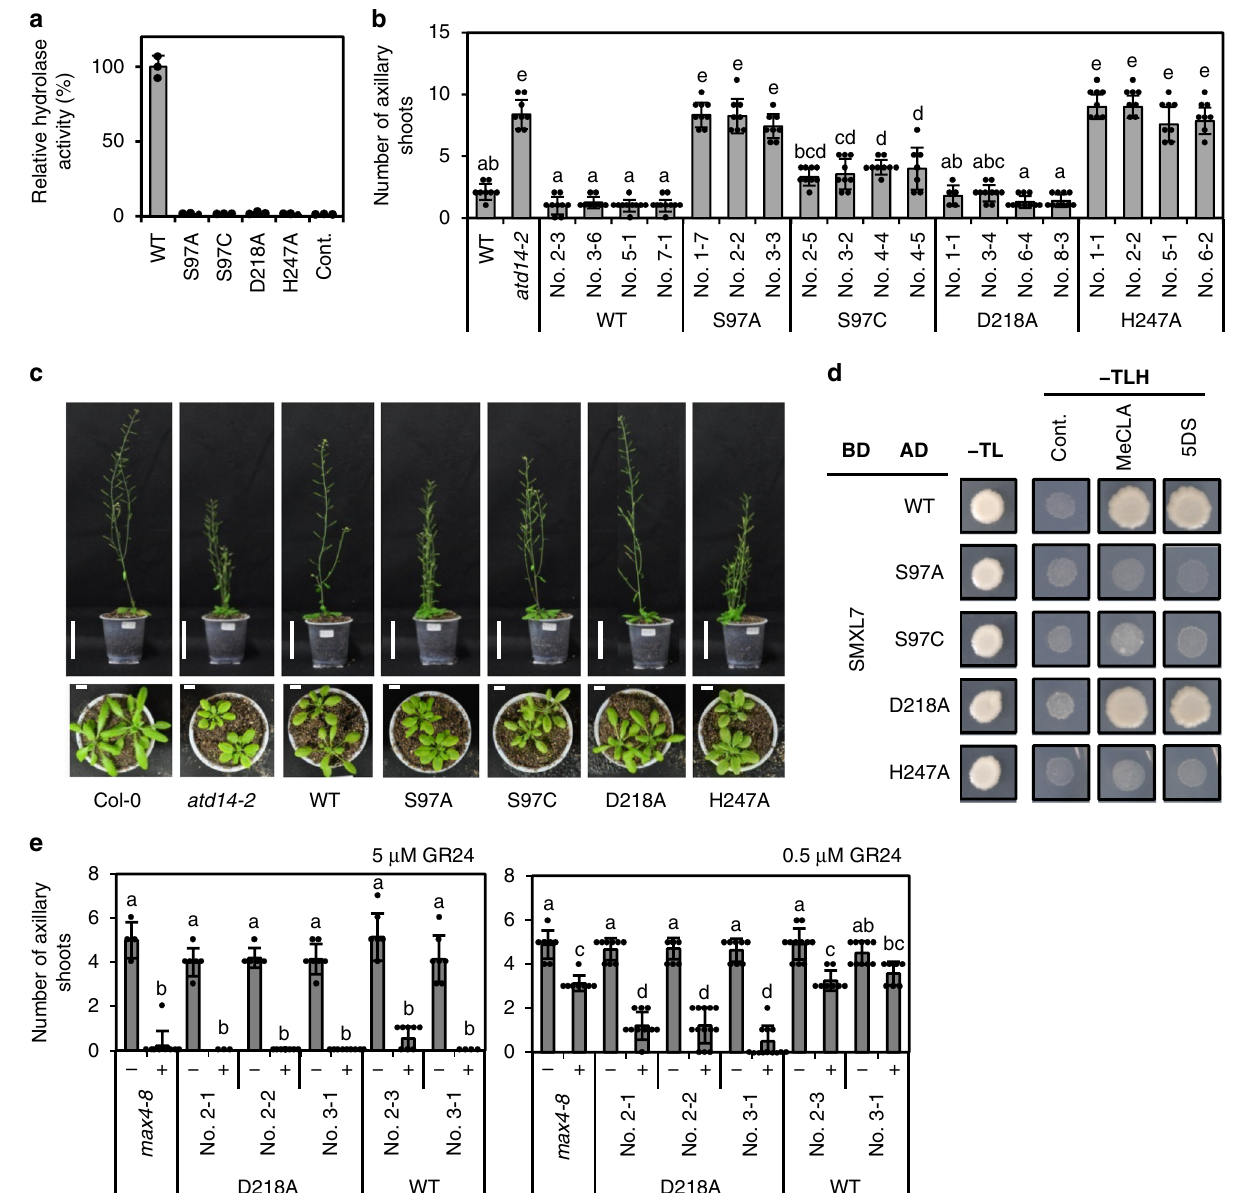
Fig. 3 In vitro and in vivo functional analysis of catalytic triad mutants of AtD14. a Hydrolysis activities of catalytic triad mutants of AtD14 using 1 μ M of 5DS as a substrate. Data are the means± SD ( n = 3). The control reaction (Cont.) is for MBP protein only. b No. of axillary shoots (over 5 mm) of Arabidopsis transgenic plants expressing each catalytic triad mutant of AtD14 in the atd14-2 mutant background. Data are the means ± SD ( n = 5 – 10, Different letters indicate signi fi cant differences at P < 0.05 with Tukey-kramer multiple comparison test.). c Phenotypes of Arabidopsis transgenic plants expressing each catalytic triad mutant of AtD14. Mature 50 days old plants phenotypes (upper panel) and leaf morphology phenotypes of 25 days old plants (lower panel) are shown. Scale bars = 5 cm (upper panel), 1 cm (lower panel). d Y2H analysis of the interaction between SMXL7 and each catalytic triad mutant of AtD14. Yeast transformants were spotted onto the control medium (SD − Leu/ − Trp ( − TL)) and selective medium (SD − Leu/ − Trp/ − His ( − TLH)) in the absence or presence of SLs (10 μ M rac -MeCLA or 10 μ M 5DS). Control (Cont.) is acetone only. e Shoot branching inhibition assays of the Arabidopsis transgenic lines expressing AtD14 WT and AtD14 D218A , respectively, in the atd14 max4 double mutants background. The bars indicate the No. of axillary shoots (over 5 mm) in the presence ( + ) or absence ( − ) of GR24 at 5 μ M (left panel) and 0.5 μ M (right panel), respectively. Data are the means ± SD ( n = 3 – 13, Different letters indicate signi fi cant differences at P < 0.05 with Tukey-kramer multiple comparison test). Source data are provided as